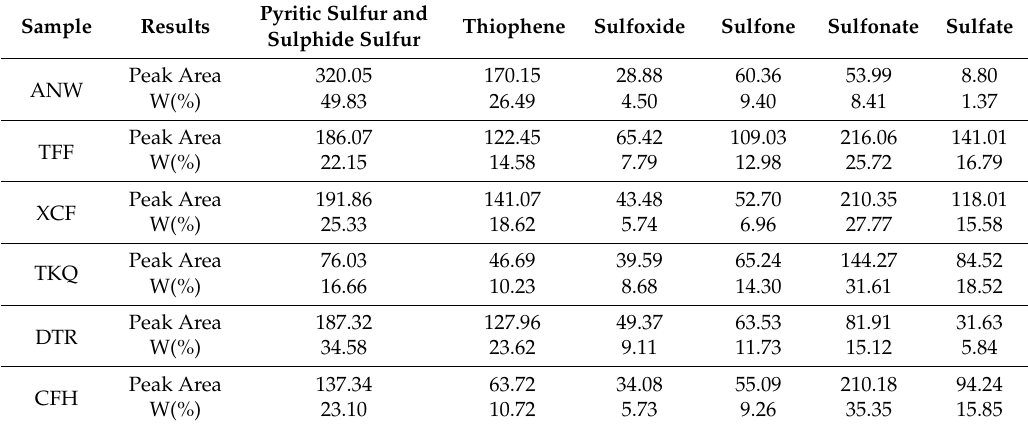
Table 1. The XPS S 2p analysis of six raw coal